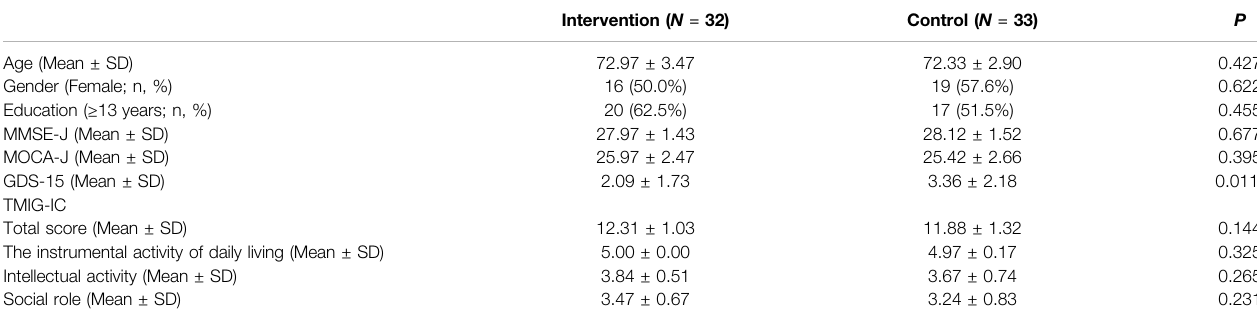
TABLE 3 | Characteristics at